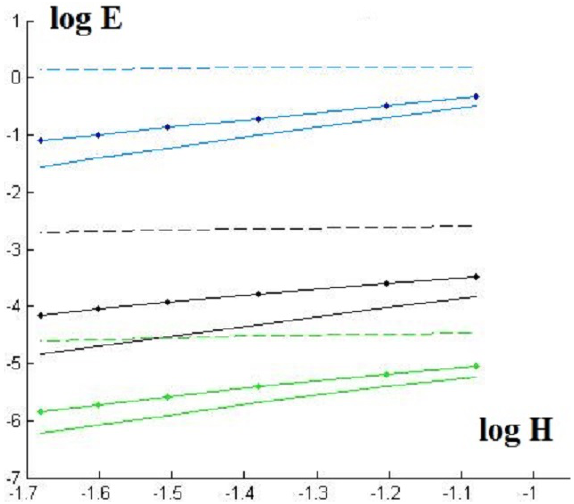
Figure 5. Distribution of v x , v y and P ; 2-D case, exponentially varying viscosity, high-viscosity contrast ( η 2 = η 3 = 100) v xe = v xn − v xa , v ye = v yn − v ya , P re = P rn − P ra . solution ( v x,n − v x,a ,v y,n − v y,a ,P n − P a ) is related to